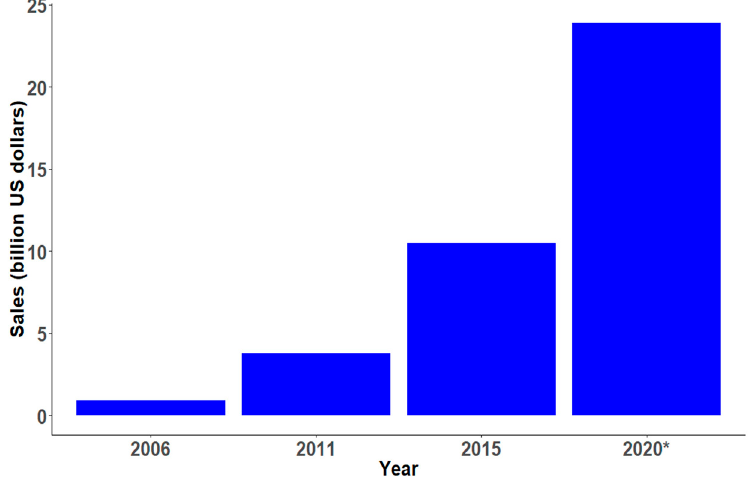
Figure 3. Gluten-free food market in the US from 2006 to 2020. (Source: Statista, 2018; * indicates projected value).